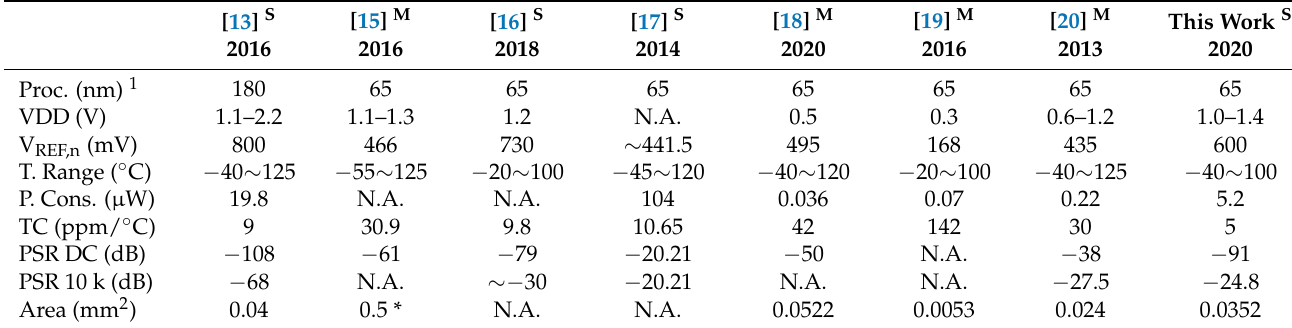
Table 1. Simulated performance compared with other works.